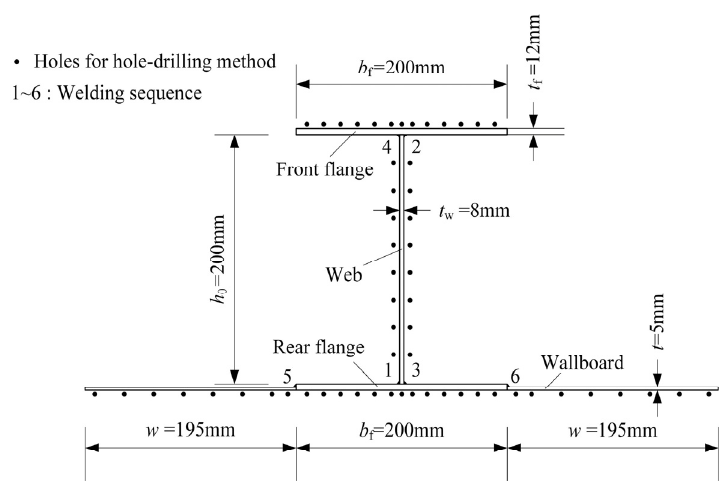
Figure 7. Schematic diagram for specimen section and distribution of holes. Table 4. Material mechanical properties and welding parameters.